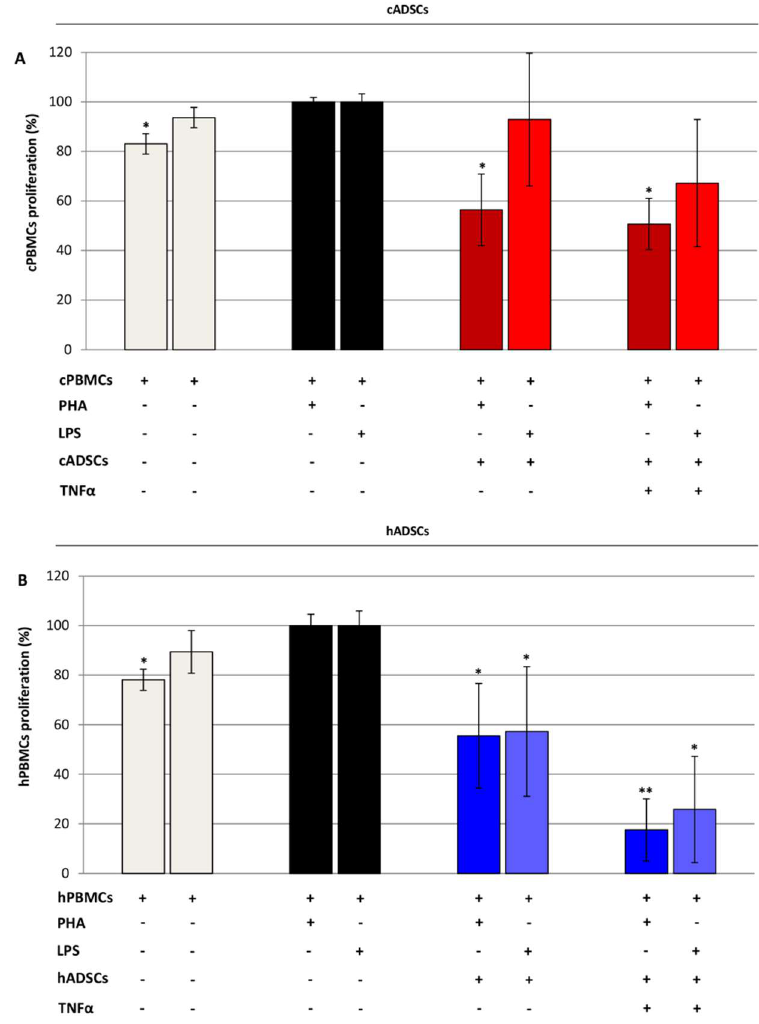
Figure 9. Proliferation of canine and human peripheral blood mononuclear cells (PBMCs) in co-culture with allogenic ADSCs (10:1 ratio). ( A ) MTS assay of cPBMCs after three days of co-culture with allogenic cADSCs at p3. cPBMCs were stimulated with phytohemagglutinin (PHA) or lipopolysacchride (LPS). ( B ) MTS assay of hPBMCs after three days of co-culture with allogenic hADSCs at p3. hPBMCs were PHA- or LPS-stimulated. The graphs report the proliferation percentage compared to stimulated PBMCs (100% proliferation). Data are expressed as mean percentage ± SD ( n = 3). * p < 0.05, ** p < 0.01 indicate statistically significant difference with respect to stimulated PBMCs.